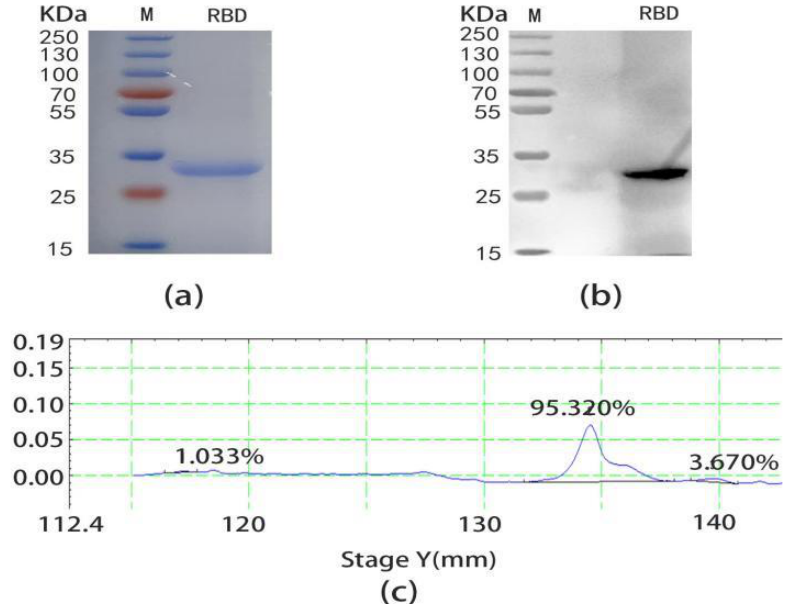
Figure 2. Expression and purification of SARS-CoV-2 RBD. ( a ) The SDS-PAGE of SARS-CoV-2 RBD induced at 37 ◦ C for 5 h and purified by Ni-NTA. After mixing 20 µ L SARS-CoV-2 RBD (10 mg) and 5 µ L 5 × loading buffer at 80 V for 20 min and 130 V for 40 min, decolorization took place after dyeing for 30 min. ( b ) The WB of SARS-CoV-2 RBD. SARS-CoV-2 RBD (10 mg) was transferred to a nitrocellulose membrane after SDS-PAGE, a rabbit anti-S1 polyclonal antibody was incubated at room temperature 2 h, and an HRP sheep anti-rabbit polyclonal antibody was diluted 1:10,000 at room temperature for 2 h. ( c ) Thin layer scanning of SARS-CoV-2 RBD. The purity of SARS-CoV-2 RBD was 95.320% and there were two impurities, 1.033% and 3.670%, respectively.